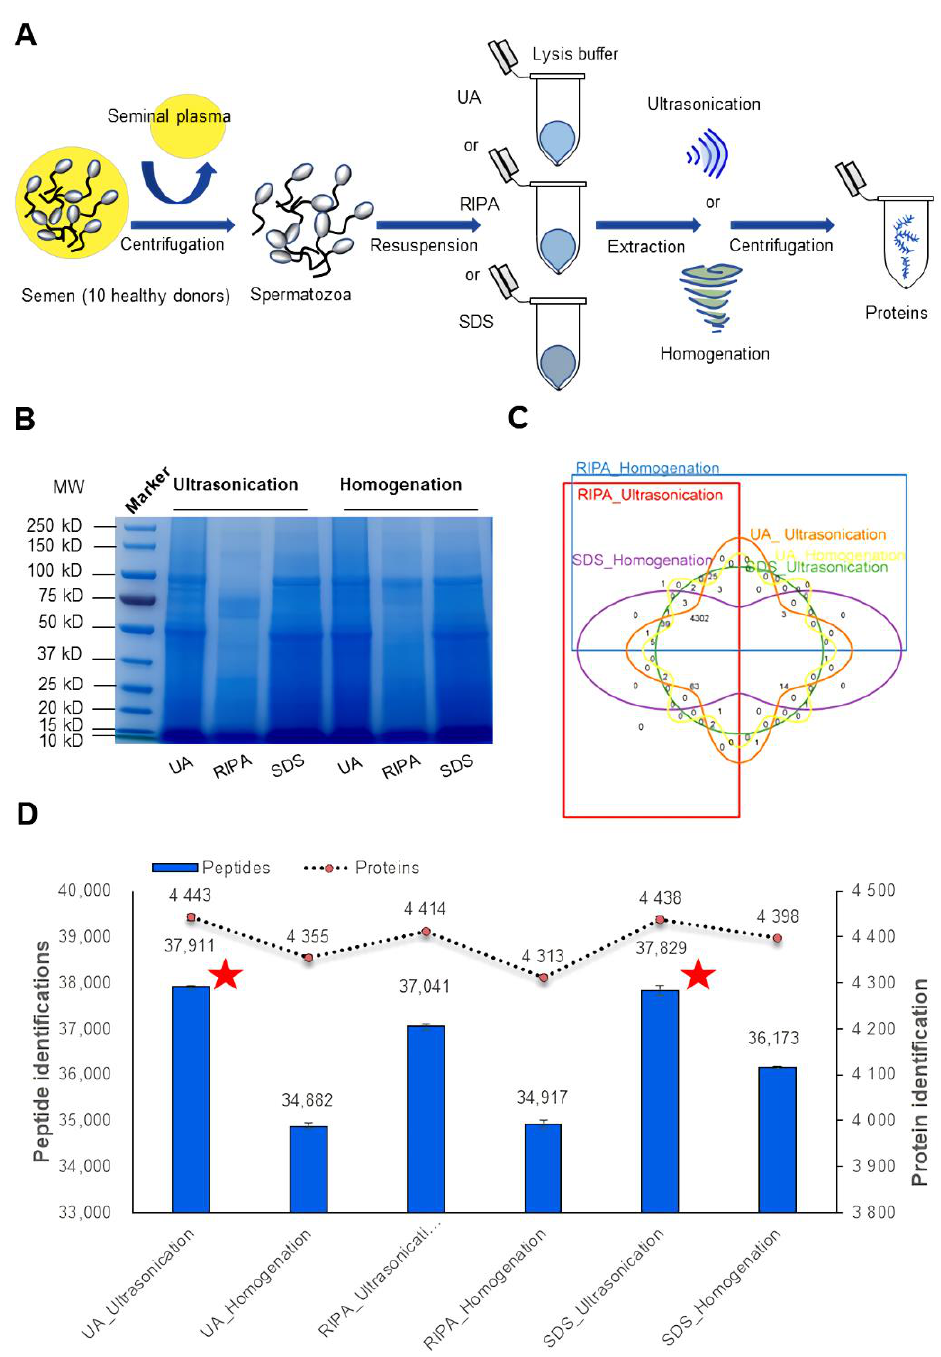
Figure 1. Comparison of quantitative proteins using different sample processing methods. ( A ), workflow of semen sample processing; ( B ), SDS-PAGE analysis of sperm proteins; ( C ), Venn plot of quantified proteins; ( D ), number of quantitative peptides and proteins.